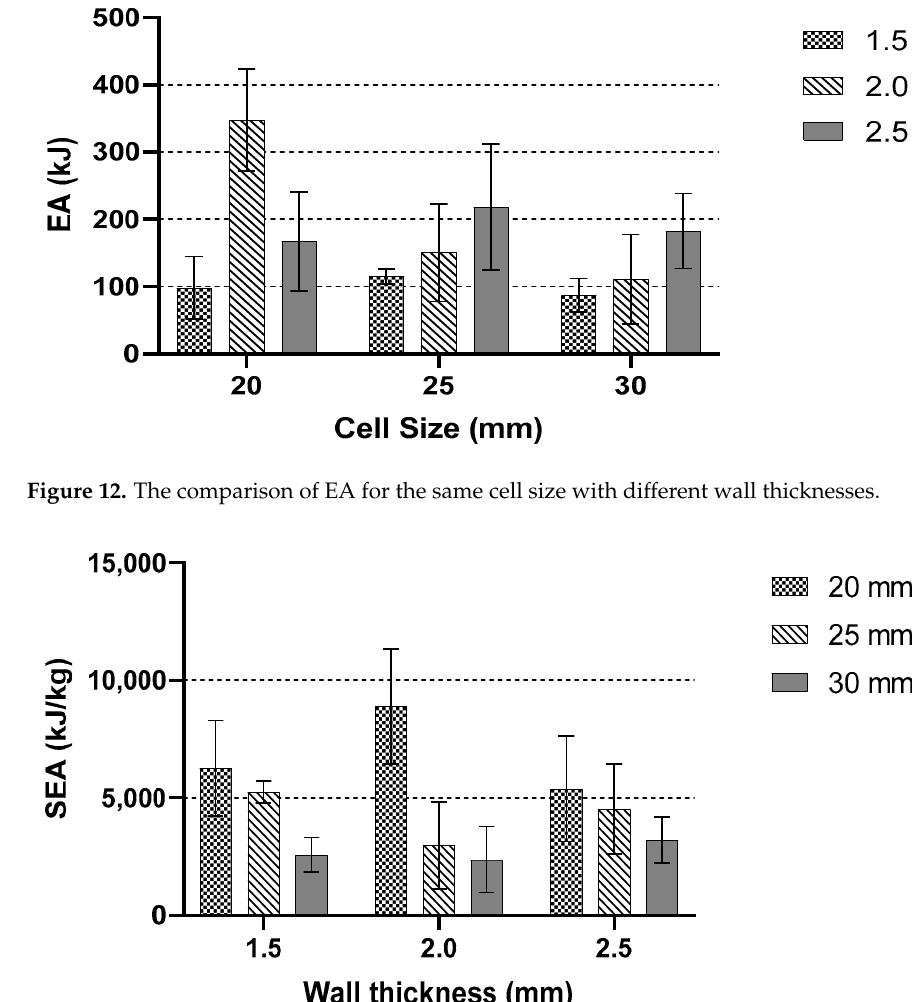
Figure 13. The SEA comparison of the same wall thickness with different cell sizes.